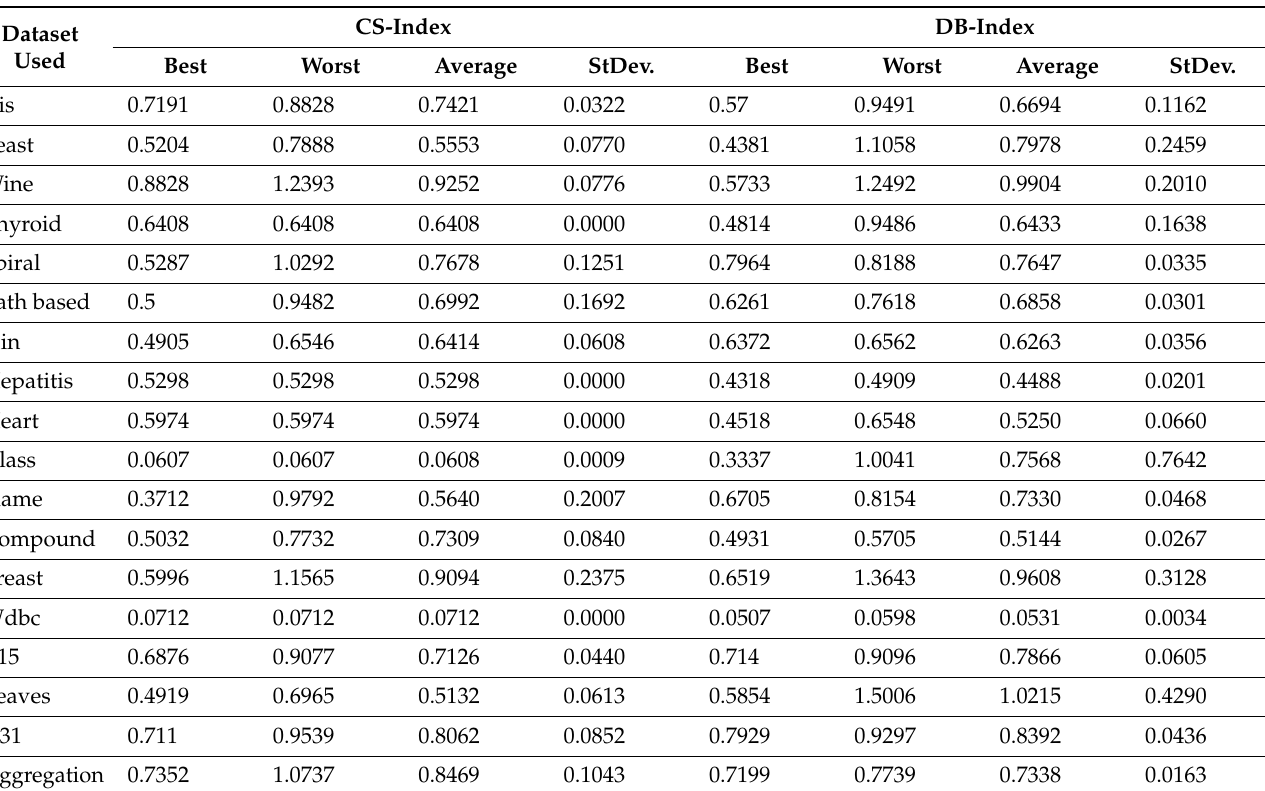
Table 5. Numerical results for HVSFAPSO based on the CS and DB validity indices over 20 indepen- dent